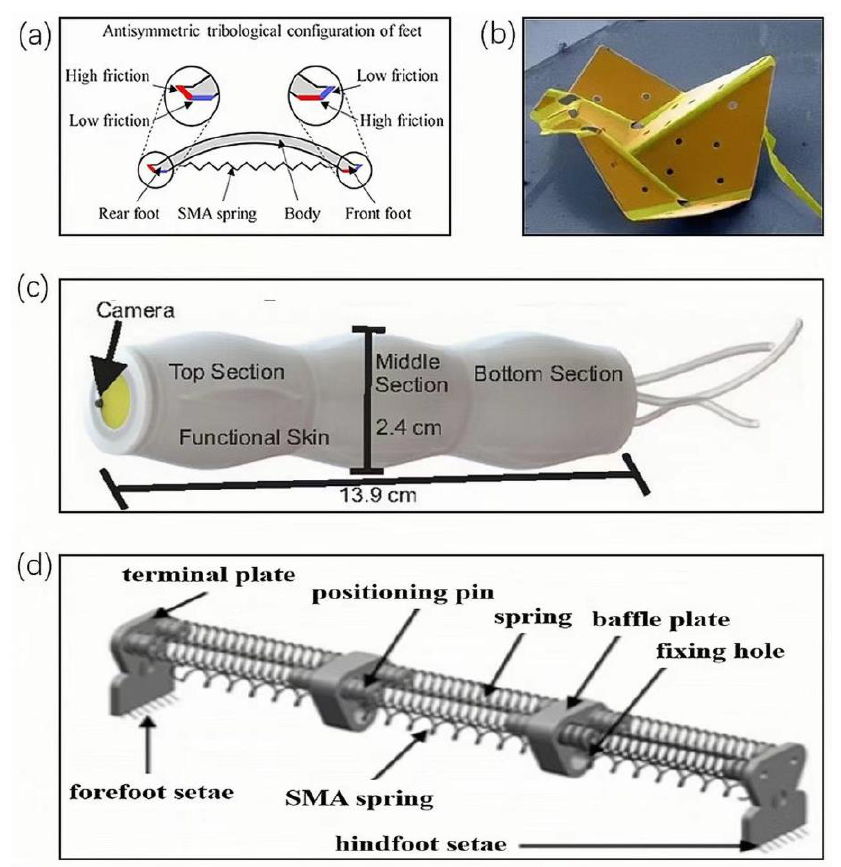
Figure 3. ( a ) Concept prototype of the bionic robot [31]. ( b ) Self-folding paper bird [33]. ( c ) Bionic- inchworm micro-robot [34]. ( d ) A soft robotic jellyfish [35].